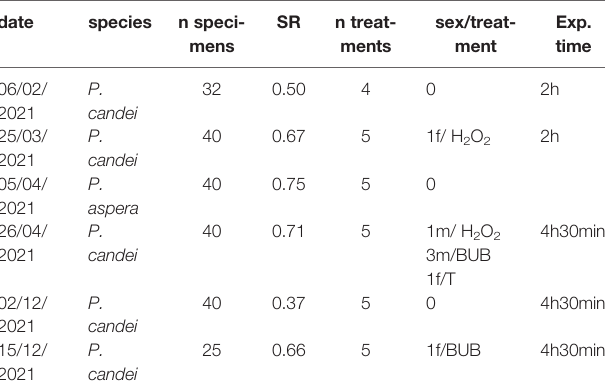
TABLE 1 | Results of induction tests performed with different treatments: bubbling (BUB), thermic shock (T), hydrogen peroxide (H 2 O 2 ), ultraviolet radiation (UV) and control (CNT).